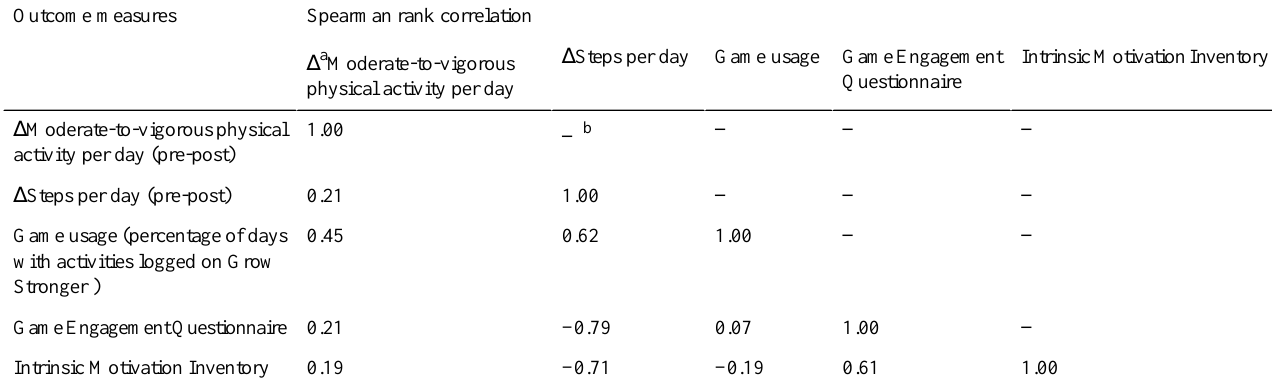
Table 7. Spearman rank correlation matrix between primary and secondary outcomes in the experiment